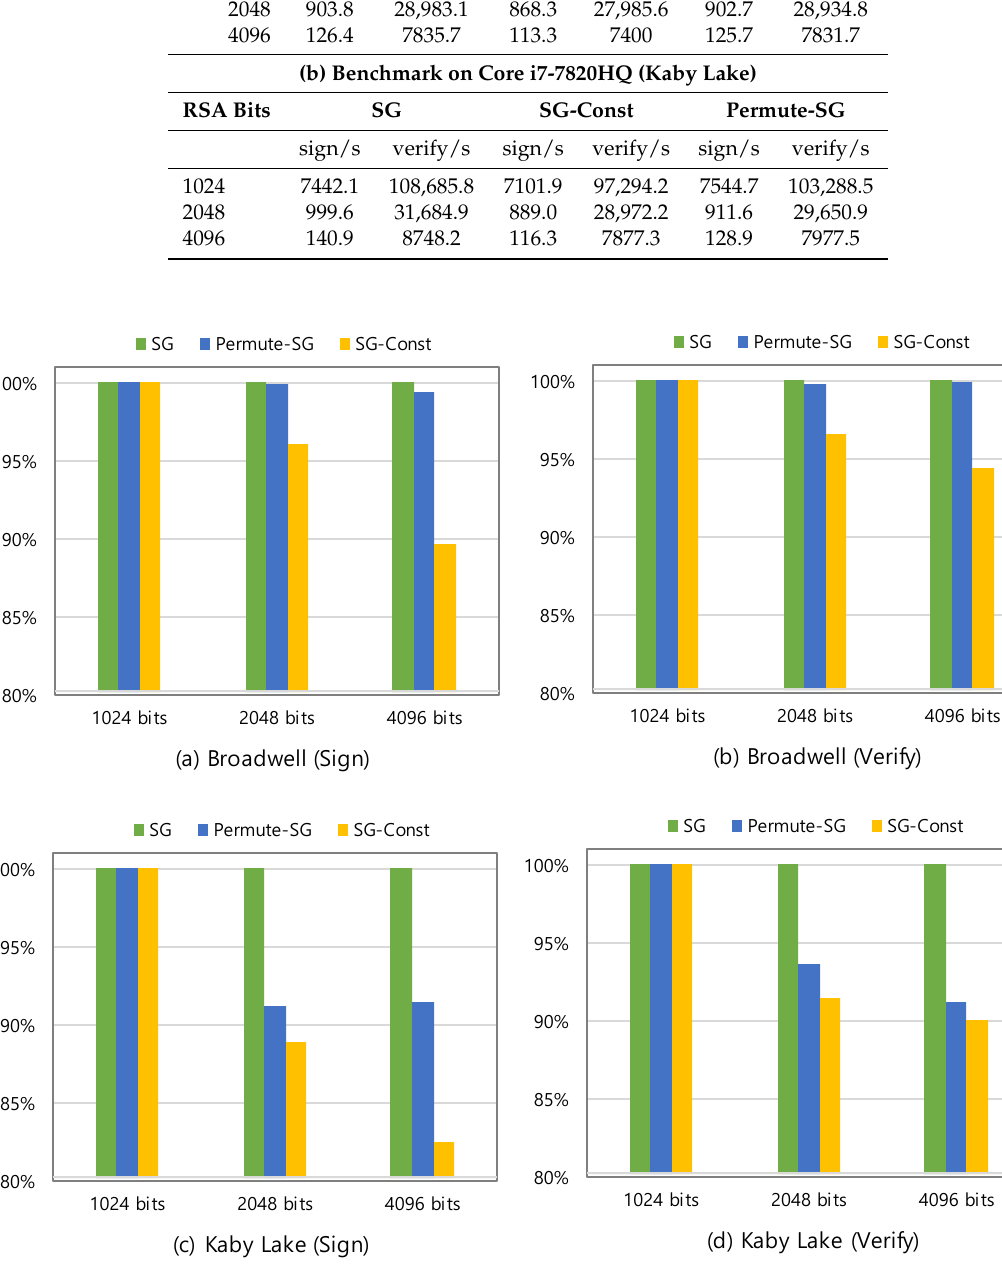
Figure 3. Comparison in the benchmarking results of scatter-gather